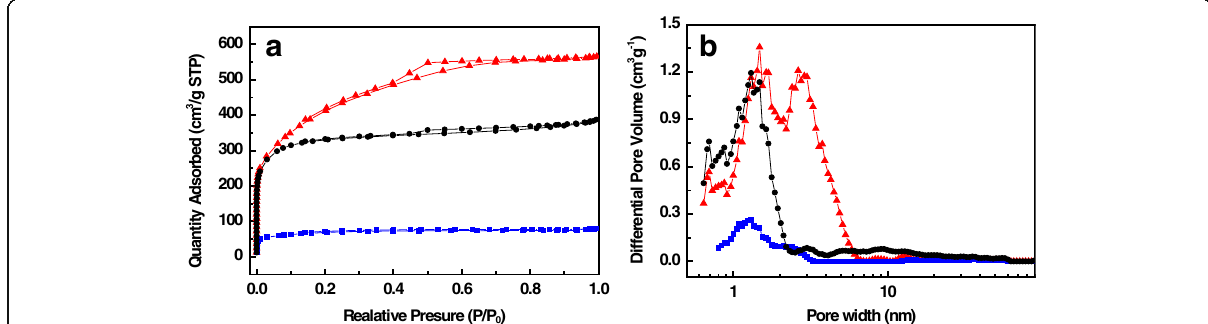
Fig. 4 Nitrogen adsorption-desorption tests. a Nitrogen adsorption-desorption isotherms at 77 K and b their corresponding PSD curves of the CGACF ( red line and symbol ), CGCF ( blue line and symbol ) and AC ( black line and symbol )